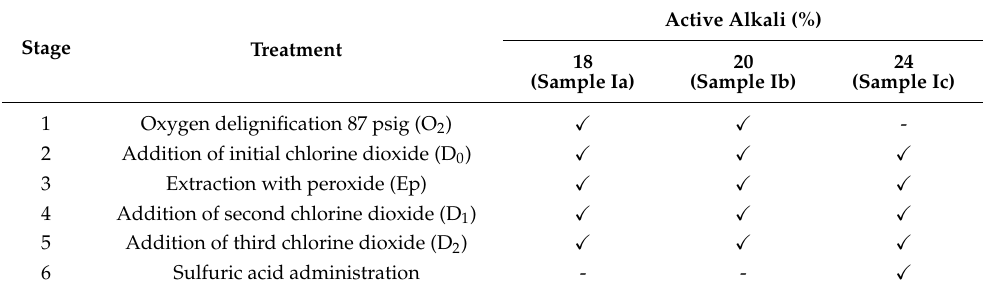
Table 3. Process bleaching is carried out in 6 stages on several